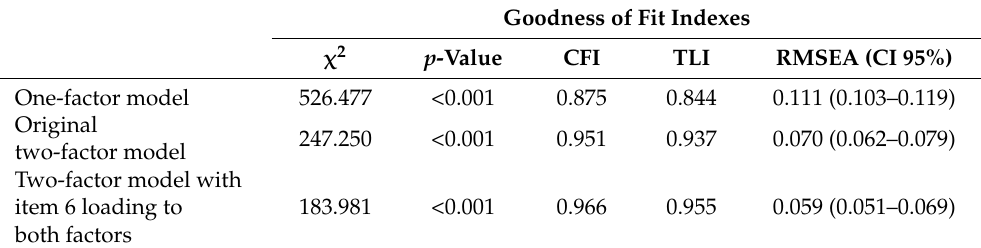
Table 5. Comparison of the Confirmatory Factor Analysis models.